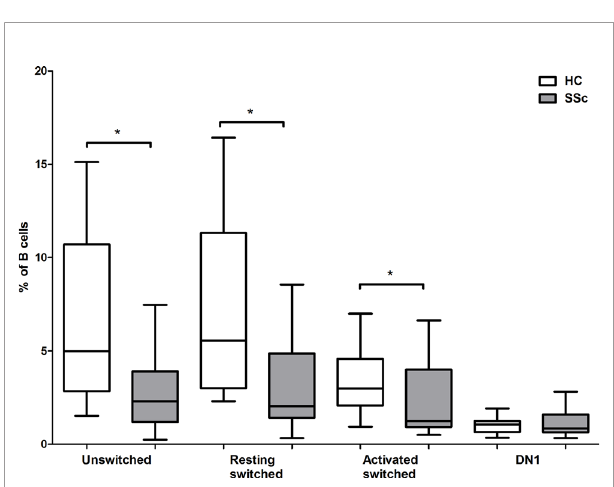
FIGURE 2 | Changes in the percentage of memory B cell subsets in SSc compared to HC. The distribution of CD19+IgDloCD27+CD38+ unswitched, CD19+IgD − CD27 − CD38+ double negative (DN) 1, CD19+IgD − CD27+CD38+ CD95 − resting switched and CD19+IgD − CD27+CD38 − CD95+ activated switched memory B cells are shown in HCs (n = 13) and in SSc patients (n = 21). The boxes show interquartile ranges (IQR), the horizontal lines represent medians and the whiskers indicate the lowest and highest values. *p <0.05.